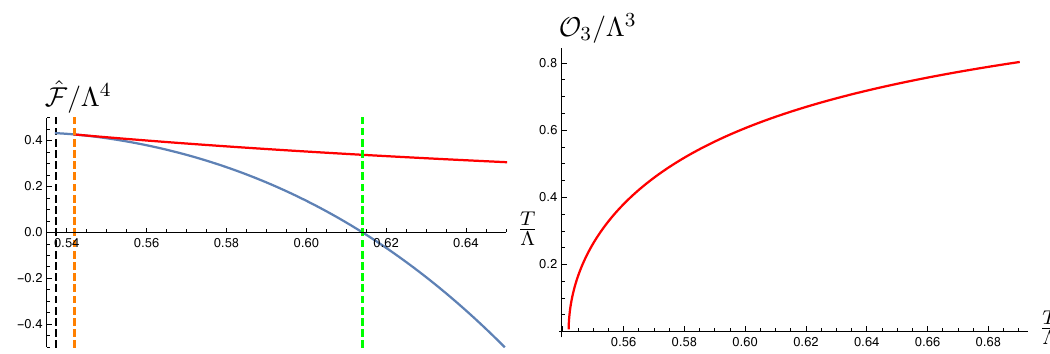
Figure 1 . Phase diagram of the cascading gauge theory plasma in canonical ensemble. Solid blue line represents deconfined, chirally symmetric phase of the theory — the gravitational dual to these thermal states is a Klebanov-Tseytlin black hole. Solid red lines represent deconfined phase of the theory with the spontaneously broken chiral symmetry — the gravitational dual to these thermal states is a Klebanov-Strassler black hole. Left panel shows the free energy density versus the temperature of the symmetric and the symmetry broken phases. The vertical dashed green line indicates the first-order confinement-deconfinement phase transition; the vertical dashed orange line indicates the onset of the perturbative instability of the chirally symmetric phase; the vertical dashed black line indicates the onset of the instability of sound waves in chirally symmetric phase of the cascading plasma. Right panel shows a critical behavior of one of the dimension-3 condensates in the chiral symmetry broken phase of the cascading